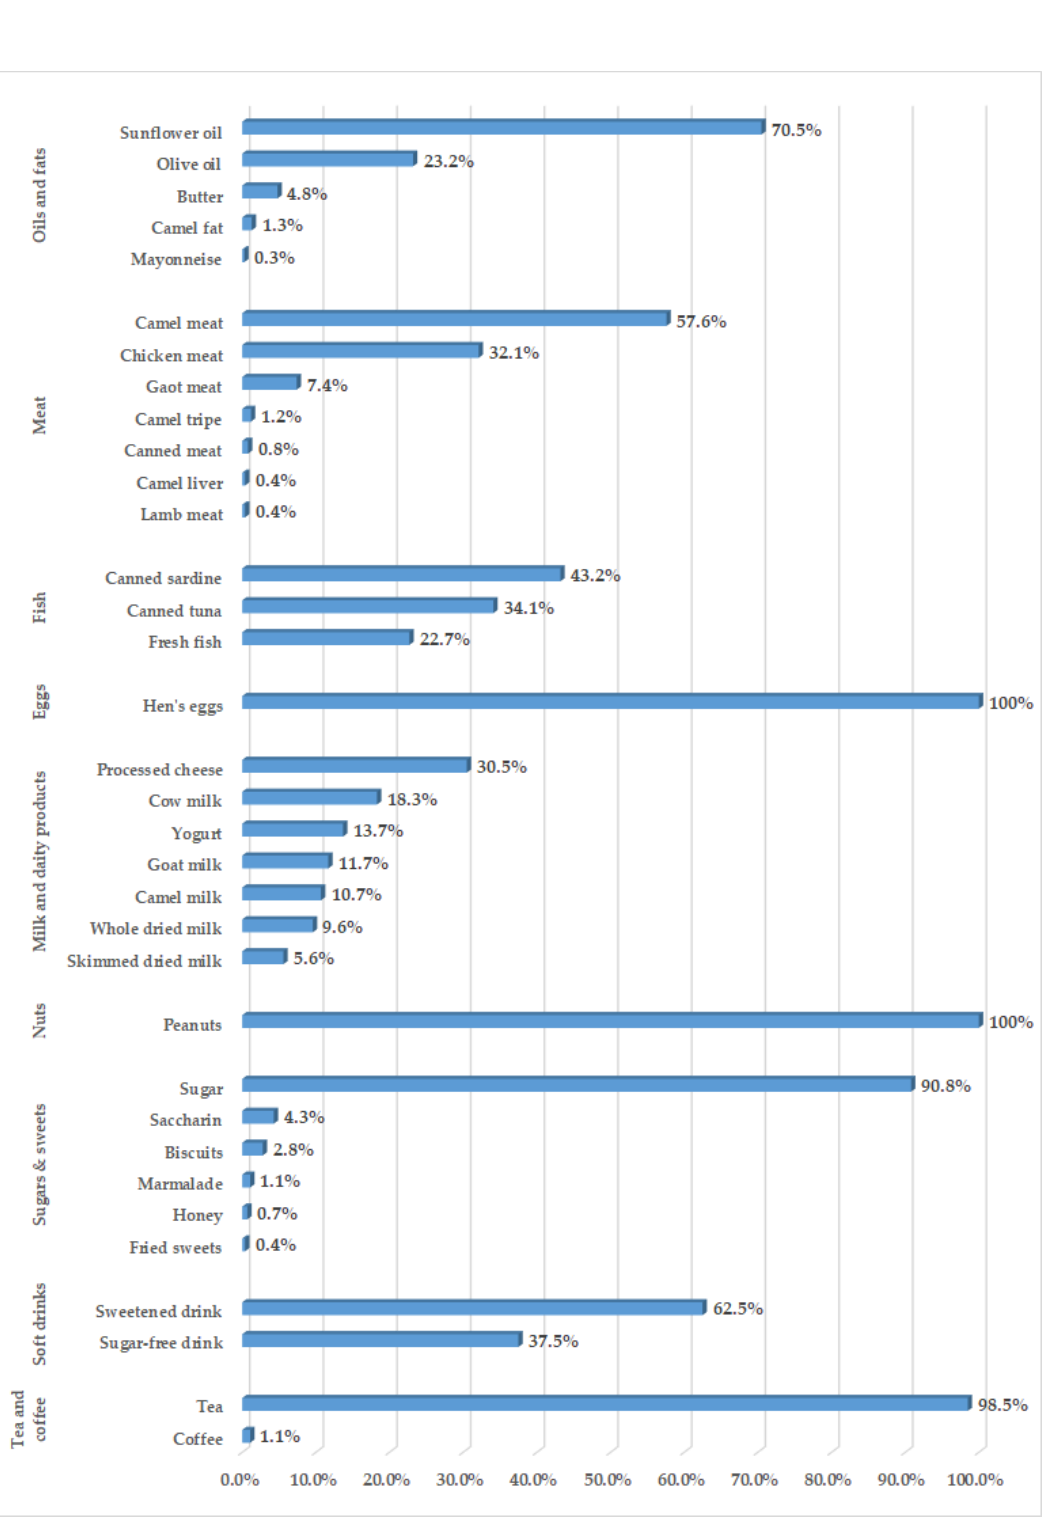
Figure 2. Frequency of consumption of each food item within each food group category.